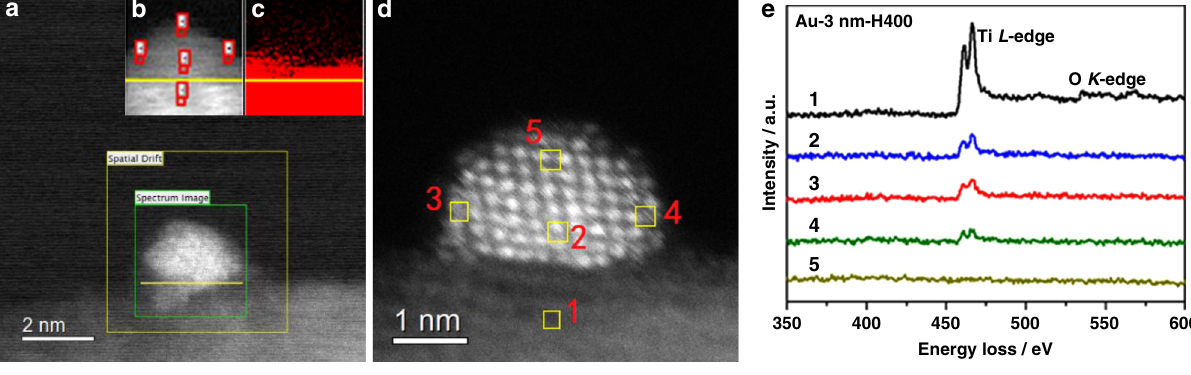
Fig. 3 EELS mapping analysis of Au-3 nm-H400 sample. a Survey image for the EELS mapping test, b the EELS spectrum image, c the EELS elemental map for Ti, d the corresponding high-angle annular dark- fi eld scanning transmission electron microscopy (HAADF-STEM) image, and e the extracted EELS spectra (background subtracted) of the selected positions (red mark) in ( b ), as also marked by yellow squares in ( d ). The yellow lines in ( a – c ) mark the interface of Au NP and TiO 2